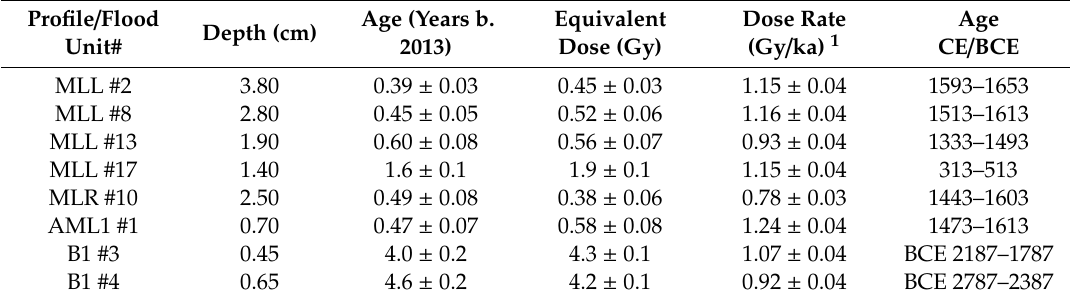
Table 2. Results from optically stimulated luminescence dating applied to eight slackwater flood deposits in Montlle ó . The last column of this table shows the ages converted to CE / BCE to facilitate the comparison with the rest of ages reported in the